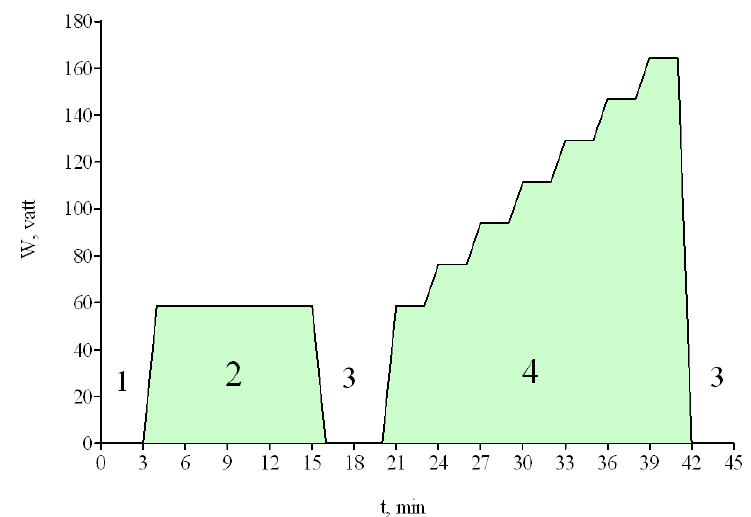
Fig.1. Diagram of athlete’s testing procedure: 1 – warming up; 2 – standard work; 3 – recreation; 4 – stage-by stage increasing work: W – power; t – time,